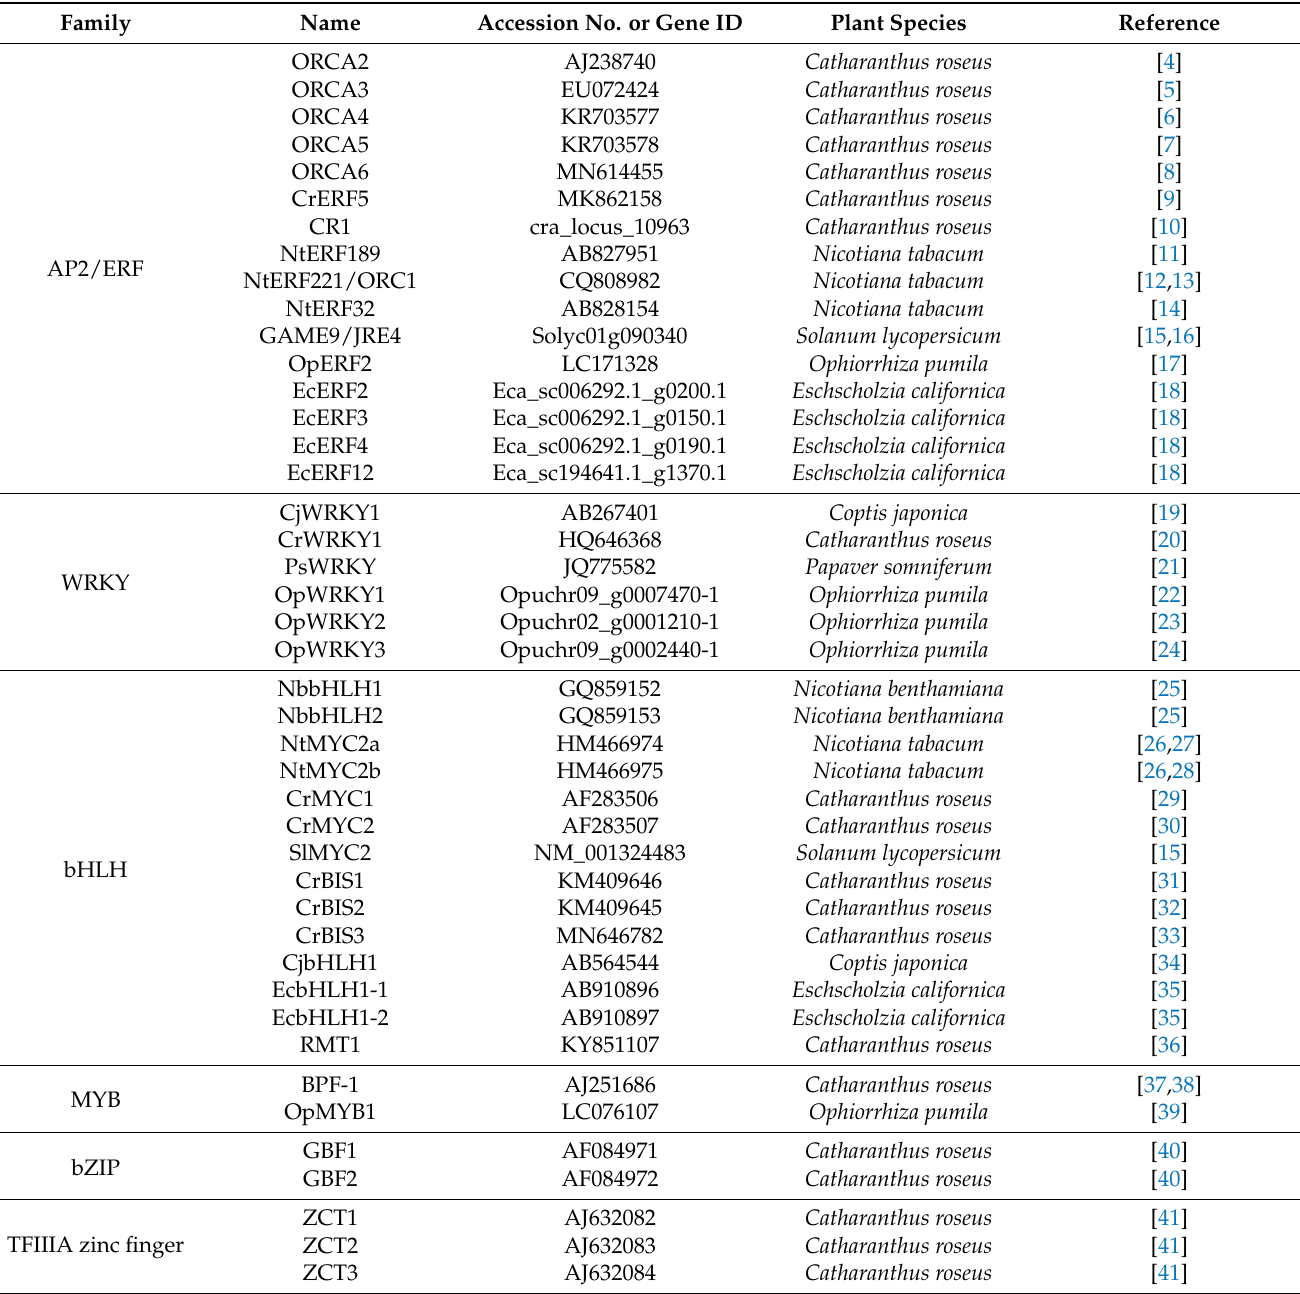
Table 1. TFs that have been identified in alkaloid